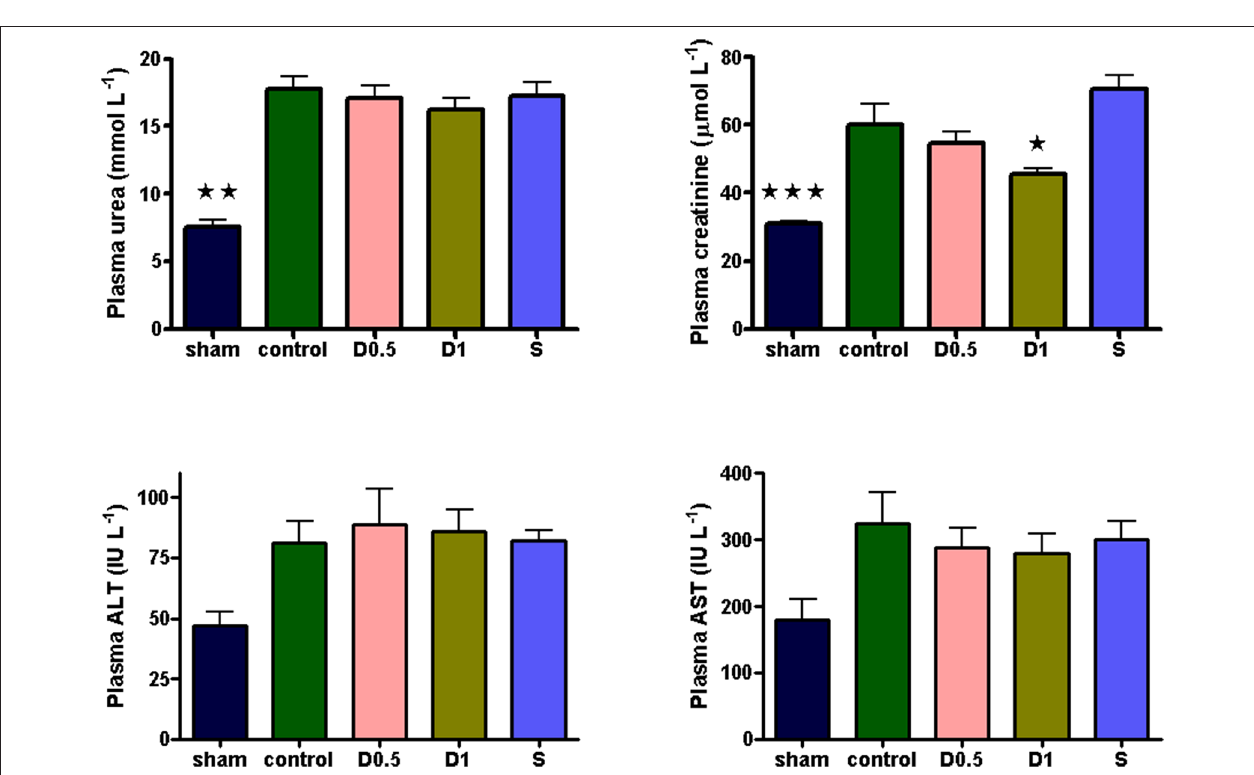
FIGURE 3 | Plasma urea, creatinine, ALT and AST sampled 5h after laparotomy and endotoxemia ( n = 6 all groups). 5h of laparotomy and endotoxemia caused significant acute kidney injury in controls. The degree of injury was significantly less in the D1 group. All data presented as mean (SEM). Plasma urea and creatinine: One-way ANOVA (Bonferroni’s post-tests, * p < 0.05, ** p < 0.01, *** p < 0.001 vs. controls). ALT: One-way ANOVA, p = 0.0246 (no groups positive in post-tests).